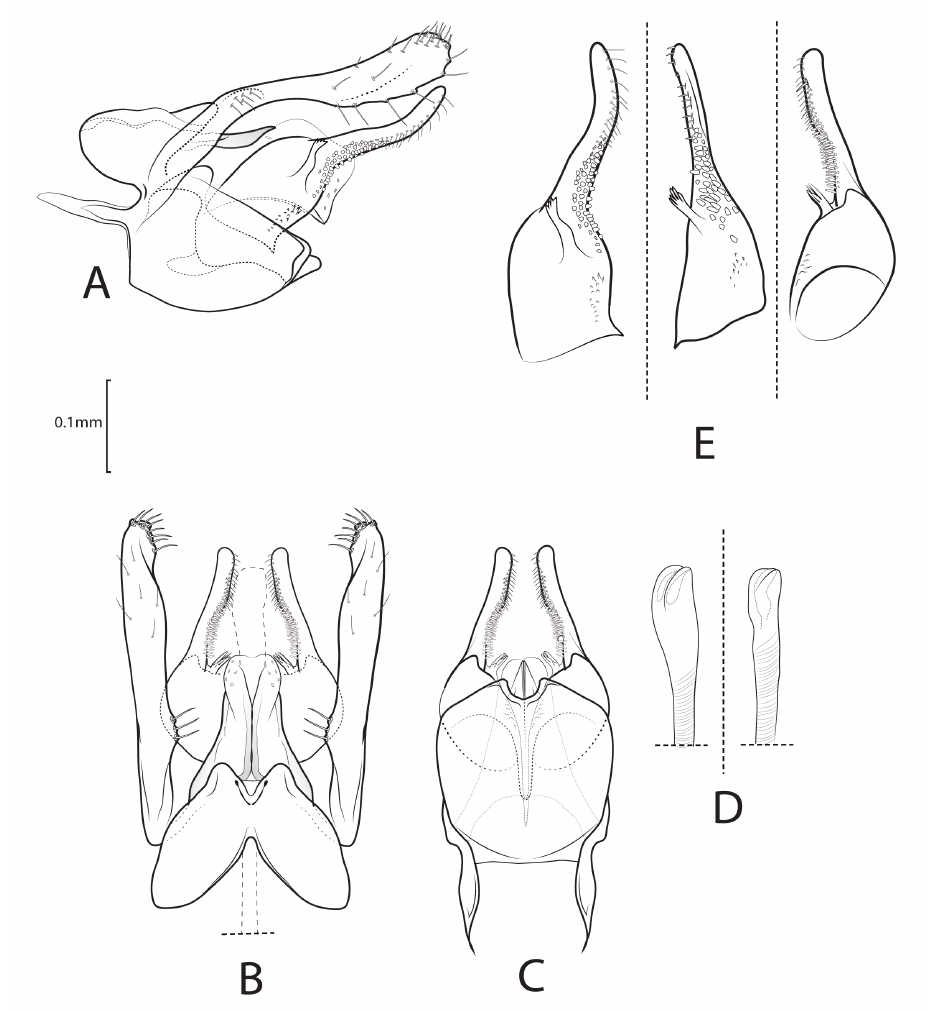
Figure 4. Xiphocentron ( Antillotrichia ) pineroi sp. nov., holotype, adult, ♂ , genitalia A left lateral B dorsal C ventral D phallus apex, left lateral and dorsal E detail of right inferior appendage mesal surface, lateral, ventro-lateral, and ventral